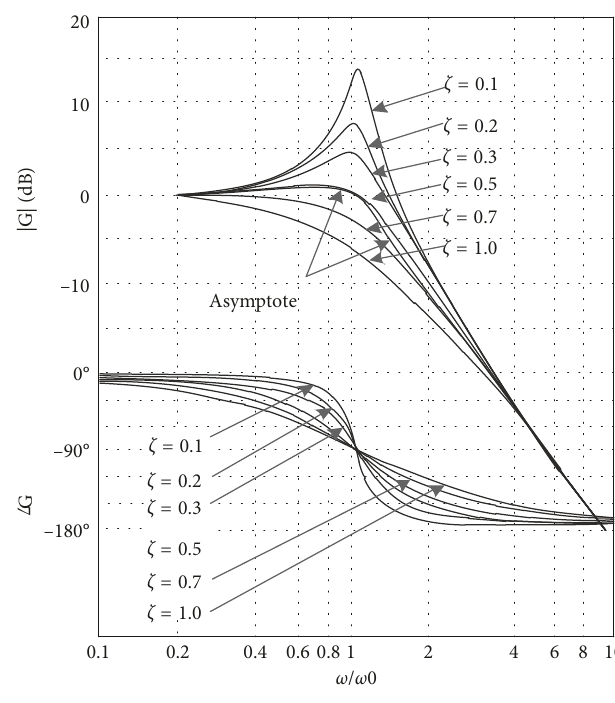
Figure 3: Bode diagram.